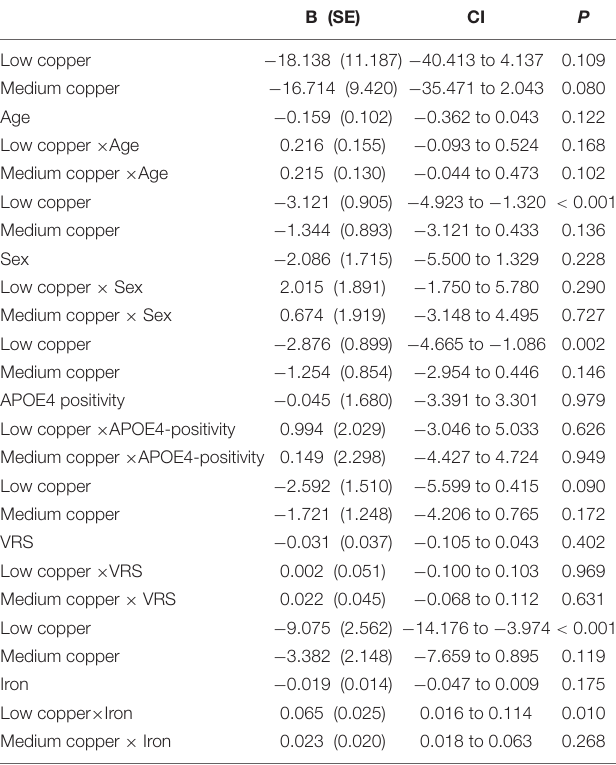
TABLE 8 | The results of multiple linear regression analyses including interaction terms between the serum copper strata and age (or sex, or APOE4-positivity, or VRS, or iron) in terms of predicting MMSE.